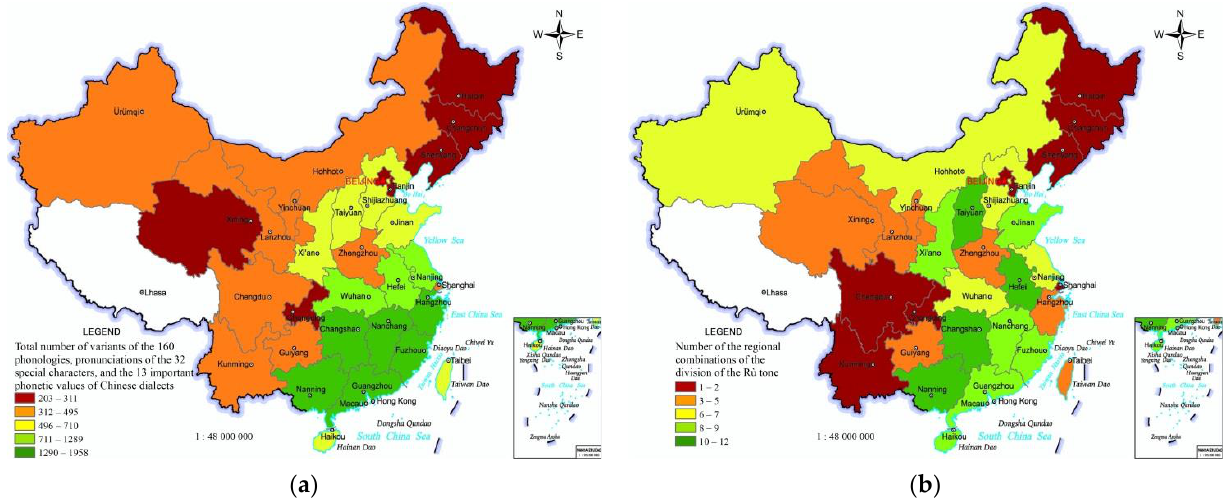
Figure 2. Distribution of phonetic diversity of Chinese dialects in China. ( a ) Total number of sources and variants of the 160 phonologies, pronunciations of the 32 special characters, and the 13 important phonetic values of Chinese dialects. ( b ) Number of the regional combinations of the division of the Rù tone of Chinese dialects.